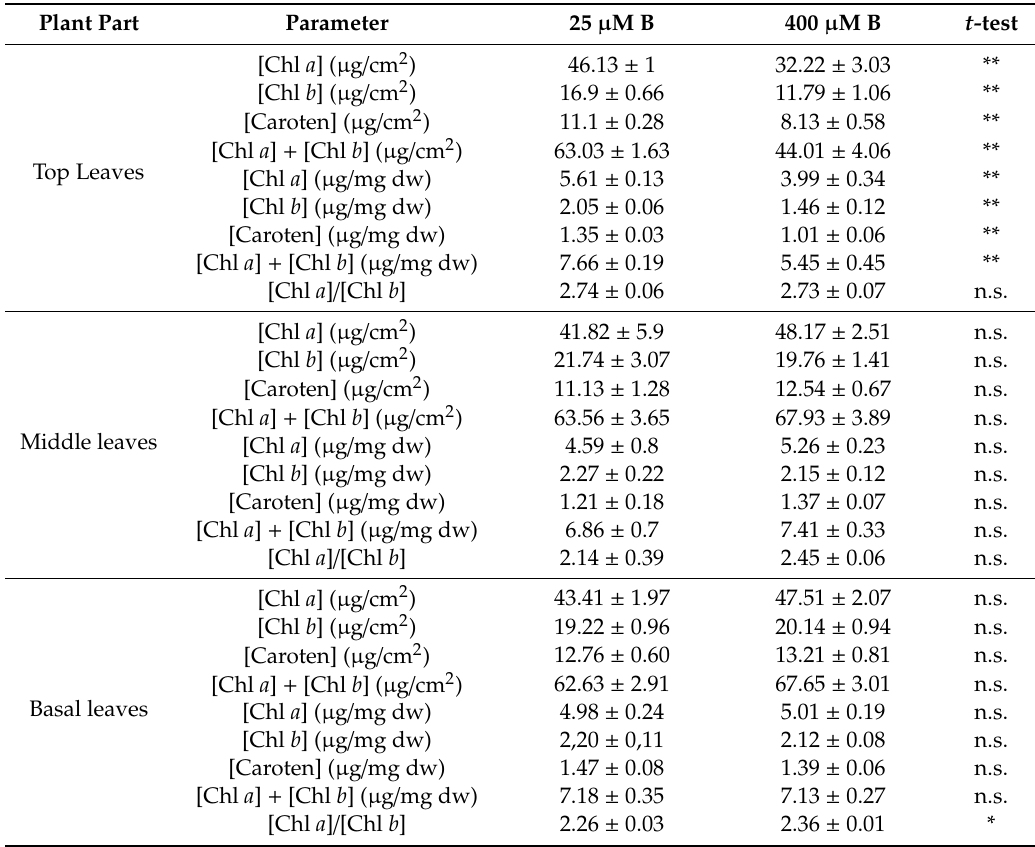
Table 4. E ff ects of B concentration in the nutrient solution (25 or 400 µ M) on photosynthetic pigments (chlorophylls and carotenoids) measured in top, middle and basal leaves of apple